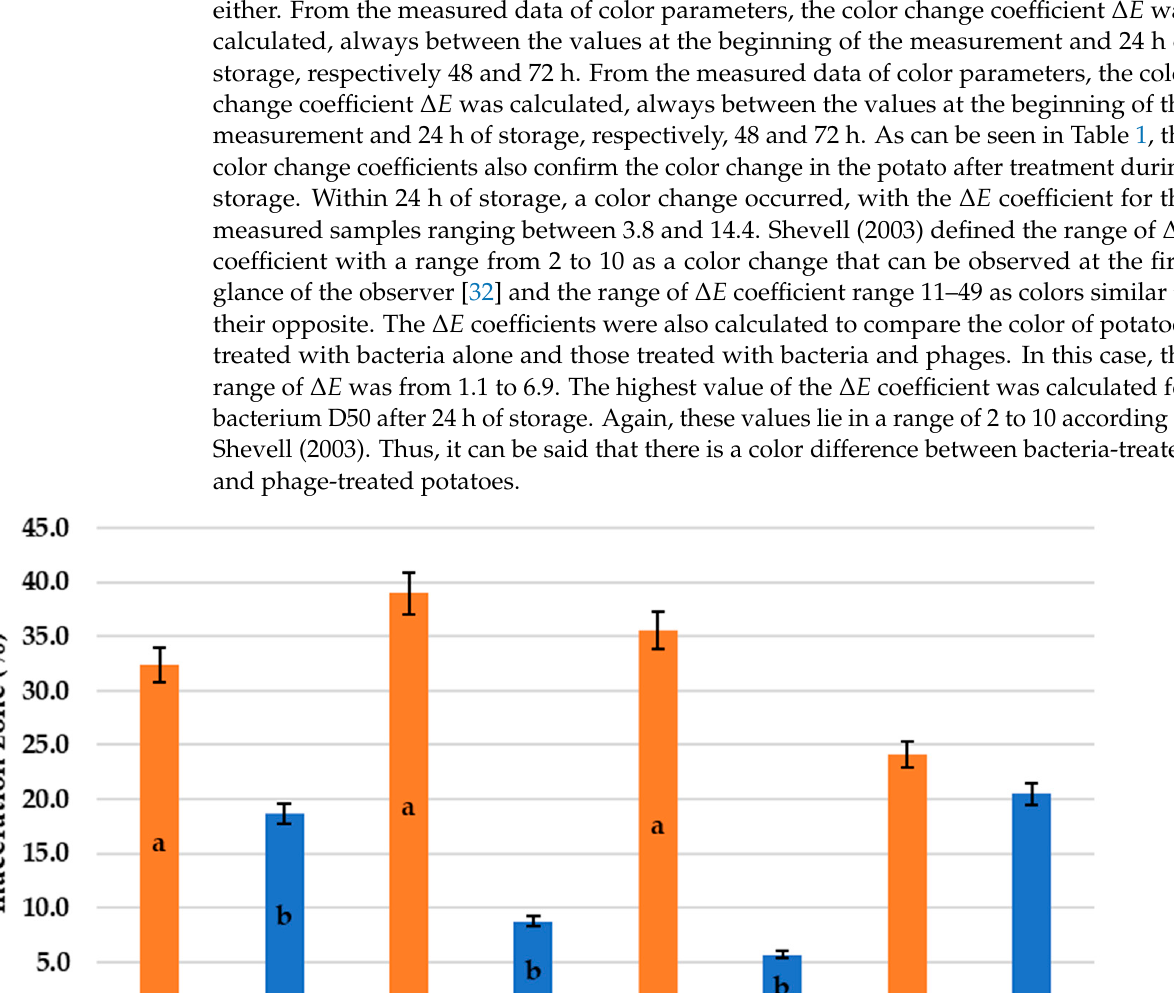
Figure 7. Mesh maceration (%) of D. dianthicola (D50, D200) and P. carotovorum (P87, P224) rots in whole potato tubers after 7 days at 25 °C; +P–phage treated; columns represent the means and the error bars represent the standard deviations; means with different lowercase letters (a or b) are significantly different between the control and phage-treated samples ( p < 0.05).